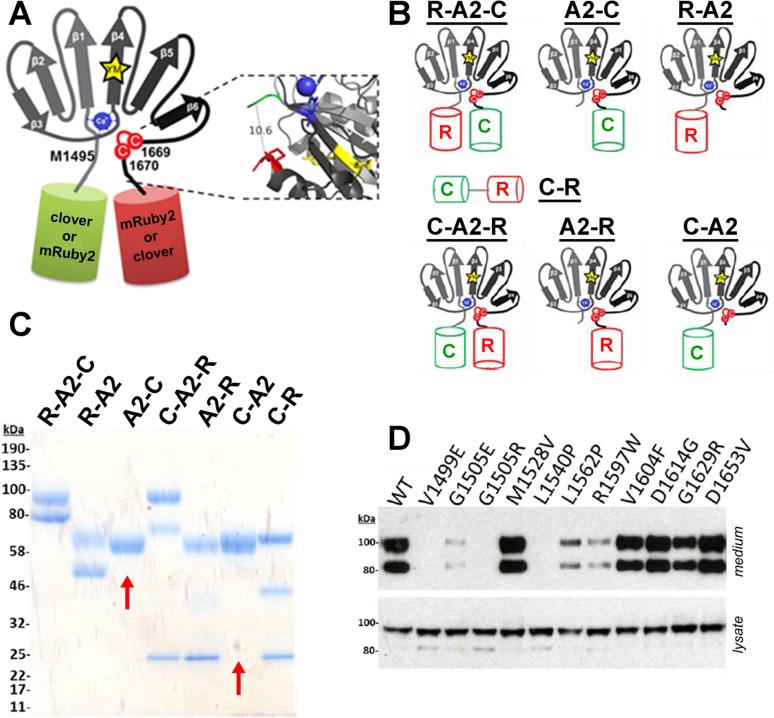
VWF A2 FRET and VWD variants.(A) Cartoon representation of the VWF A2 domain structure, the N-terminal (M1495) fused to clover (or mRuby2) and C-terminal (C1670) fused to a mRuby2 (or clover). A distance of 10.6Å between M1495 (green) and C1670 (red) was demonstrated in the crystal structure of the VWF A2 domain (3ZQK) using PYMOL. (B) Representation of the VWF A2 FRET constructs with mRuby2 positioned at the N-terminus and clover at the C-terminus (R-A2-C), deletion of mRuby2 from the R-A2-C construct (A2-C), deletion of clover from the R-A2-C construct (R-A2), clover positioned at the N-terminus and mRuby2 at the C-terminus (C-A2-R), deletion of clover from the C-A2-R construct (A2-R), deletion of mRuby2 from the C-A2-R construct (C-A2) and replacement of the VWF A2 domain with a short six amino acid linked, PKRNSG (C-R). (C) Expressed and purified protein samples were analysed by SDS-PAGE and Coomassie stained; red arrows indicate the absence of a fragmentation product. (D) The R-A2-C type 2A VWD variants were transiently transfected in HEK293-EBNA cells. After 3–5 days, the media was collected, cells washed with PBS and then lysed with 1% ipegal. Media and lysate samples were analsyed by SDS-PAGE followed by western blot using an antibody against the C-terminal Myc-tag.